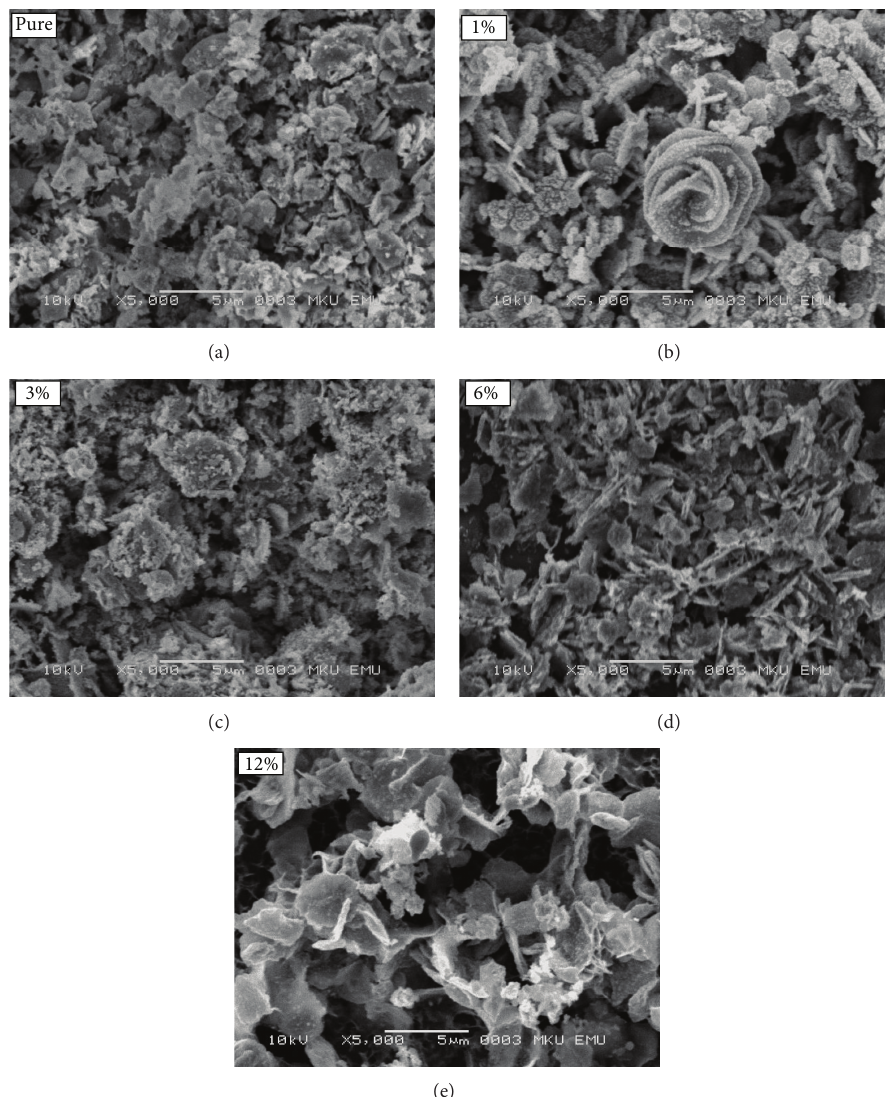
Figure 1: SEM images of CdO thin films prepared in the solutions having the saccharin concentrations of 0 (pure), 1, 3, 6, and 12%.